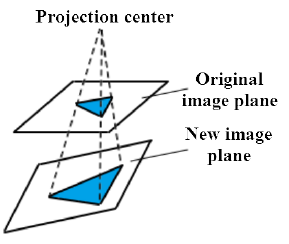
Figure 6. Schematic diagram of the perspective transformation.